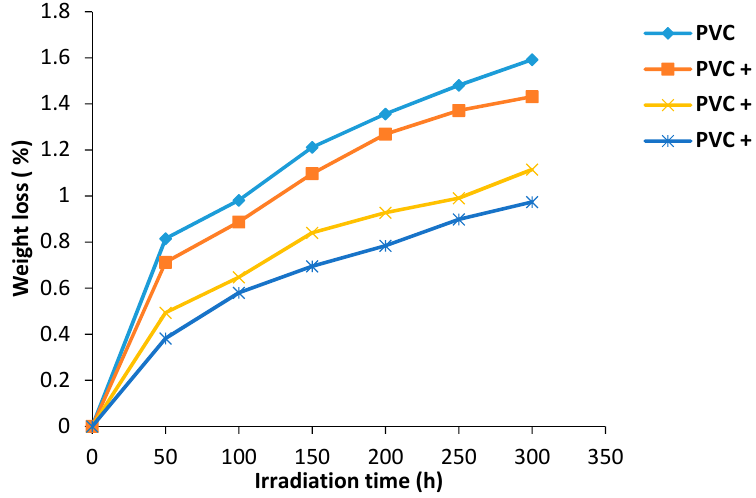
Figure 1. Changes in weight loss of PVC films versus irradiation time.